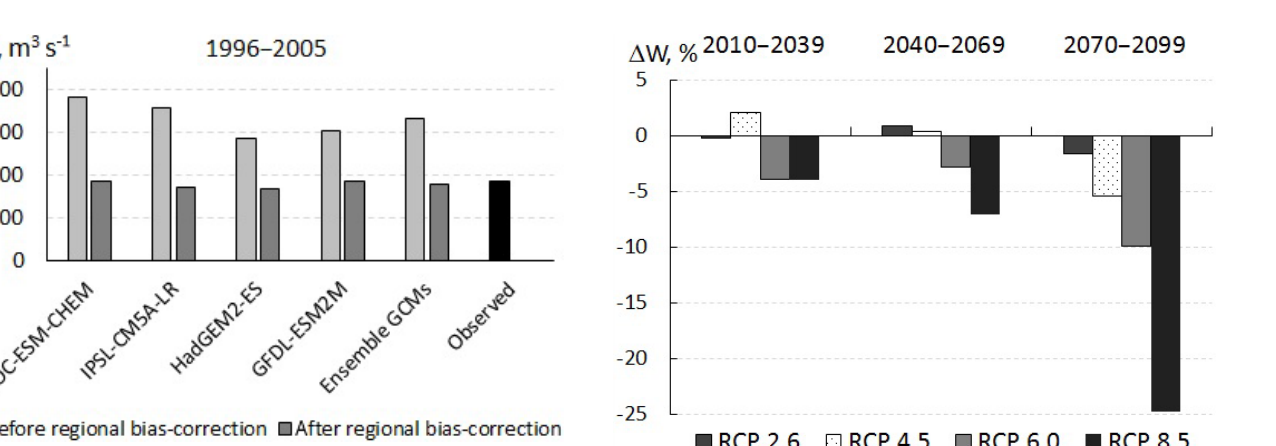
Figure 3. Mean annual runoff anomalies ( (cid:49)W , %) obtained relative to the period 1996–2005 under the